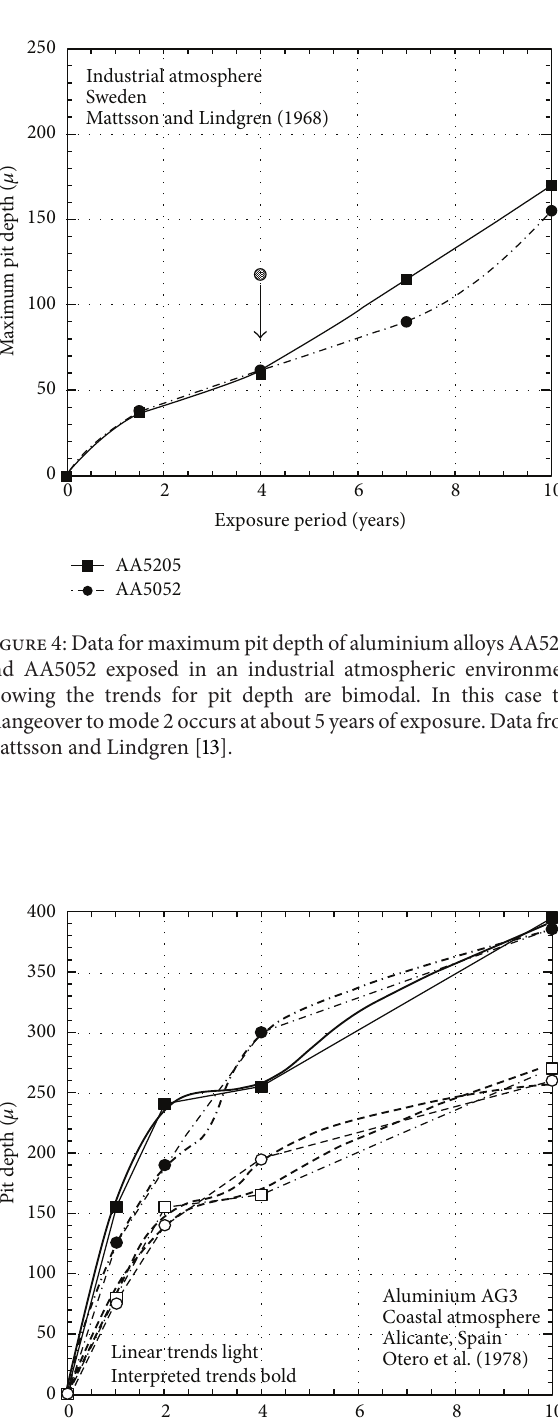
mode 2 to mode 3 (Figure 1) at about 2